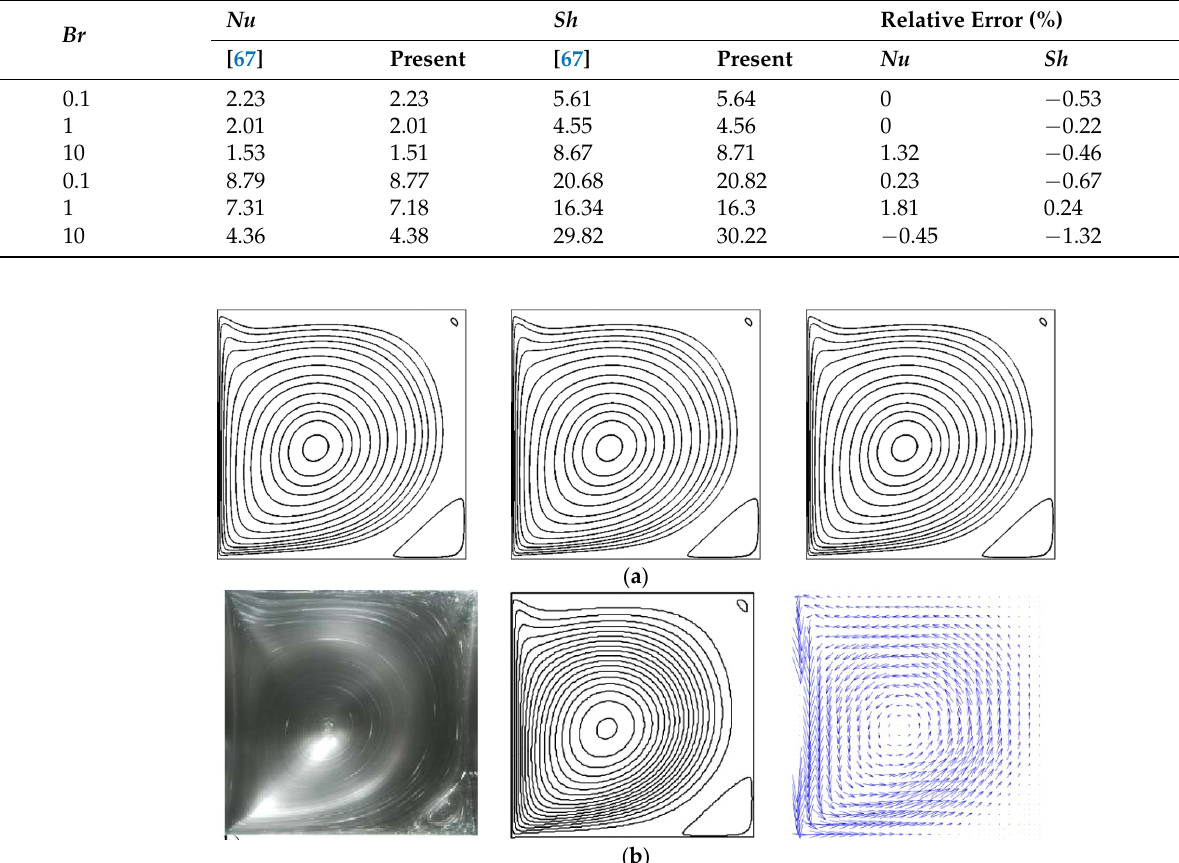
Figure 3. Mixed convention at Re = 400 from Siegmann-Hegerfeld et al. [68] and the present work. ( a ) Present work; and ( b ) Photograph (left), computed streamlines (middle), and PIV vector maps (right) from Siegmann-Hegerfeld et al.